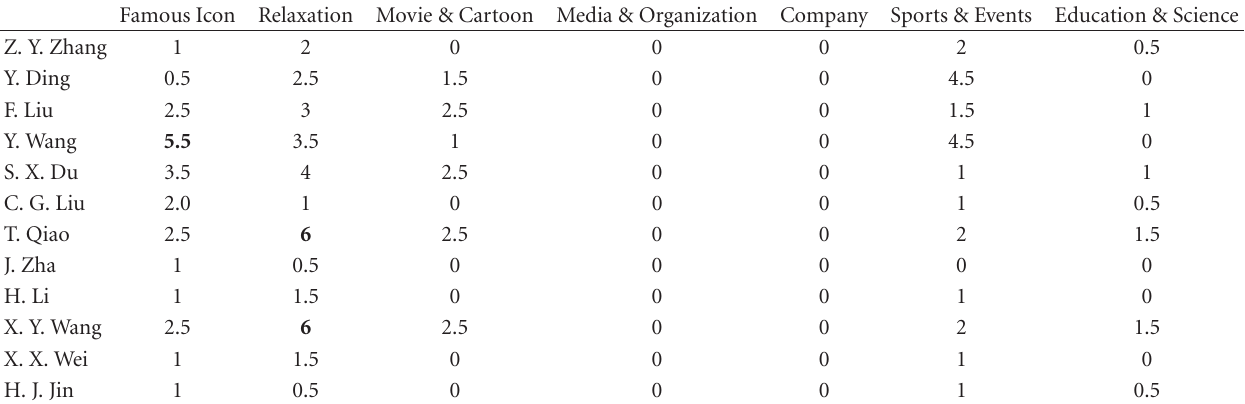
Figure 3: Supernetwork mined from RenRen. Table 1: Relation mapping between entities and